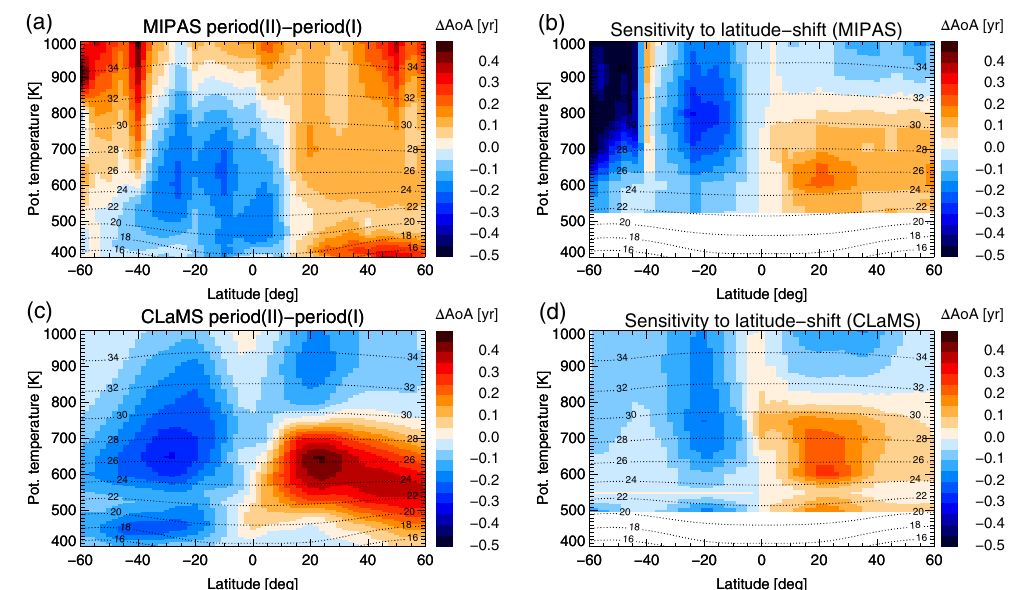
Figure 6. (a, b) Difference of MIPAS zonal mean AoA distributions between the periods I and II (a) , compared to the effect of a shift of the zonal mean AoA distribution of period I according to the altitude-dependent latitude shifts of the subtropical transport barriers as derived for MIPAS (Fig. 2b) (b) . (c, d) The same for CLaMS zonal mean